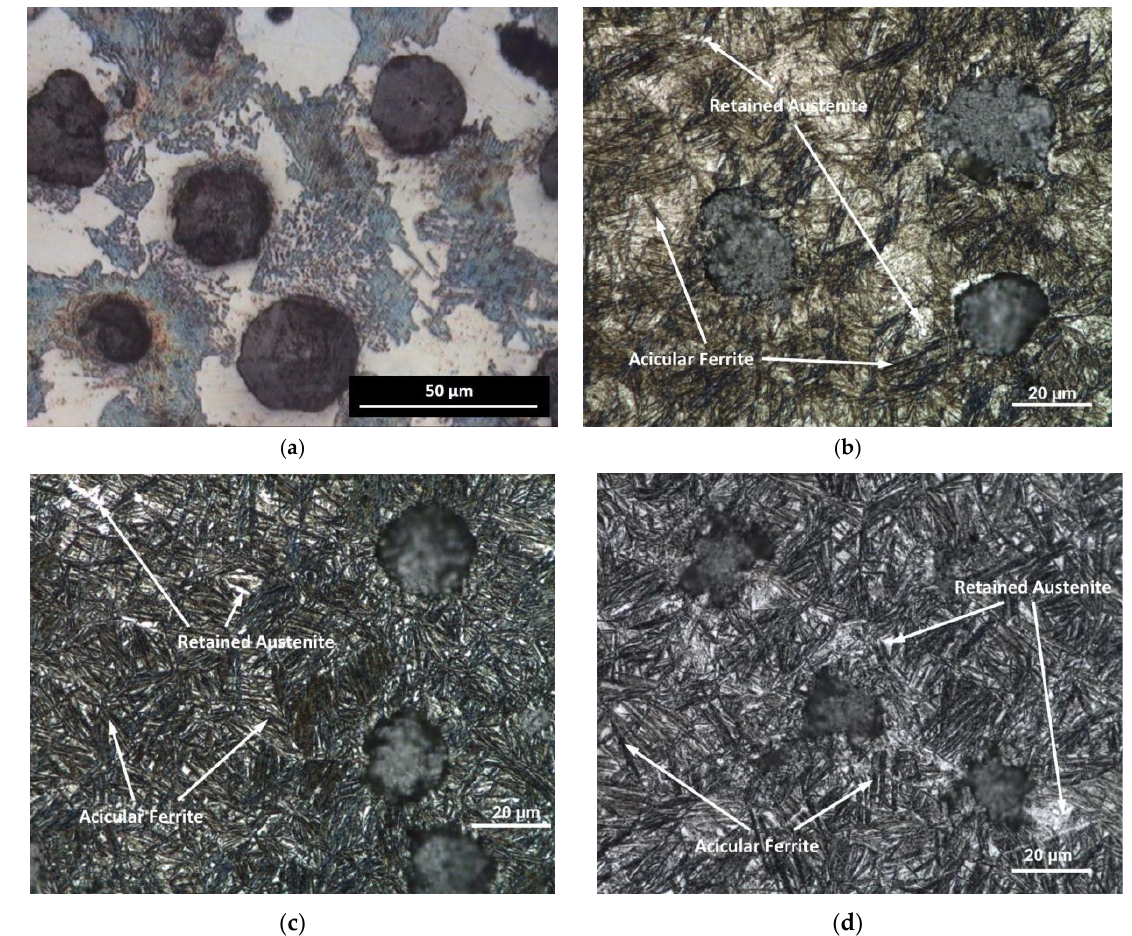
Figure 5. The optical microstructures of ADI: ( a ) as-cast ductile cast iron structure, austempered at different temperatures ( b ) 270 °C, ( c ) 300 °C, and ( d ) 330 °C.